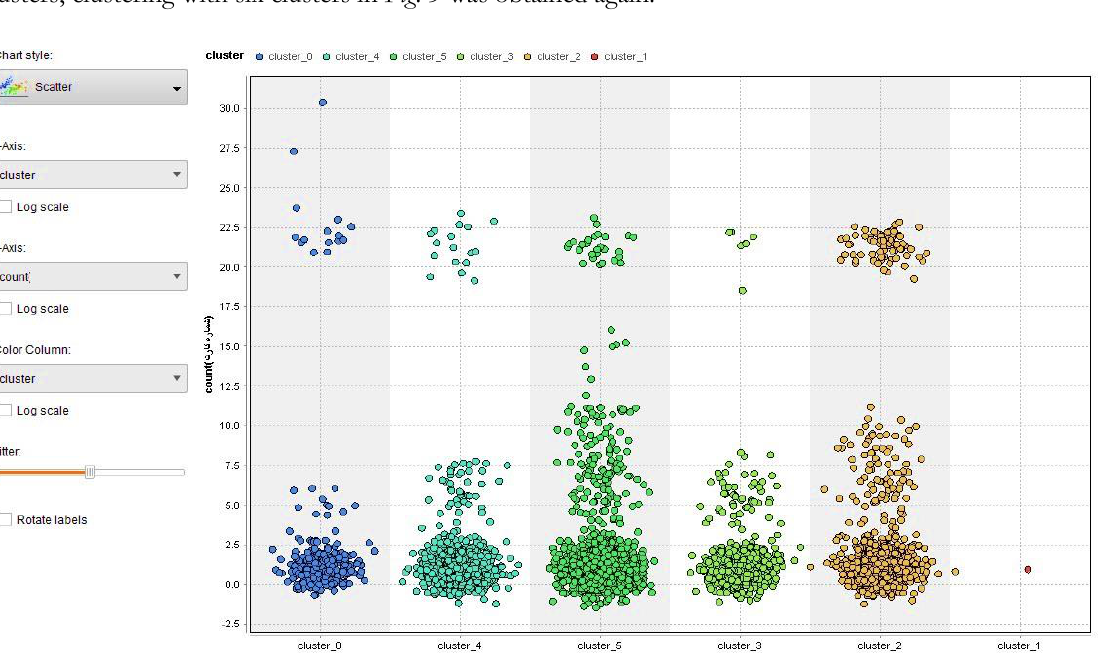
Fig. 5. Card distribution diagram after